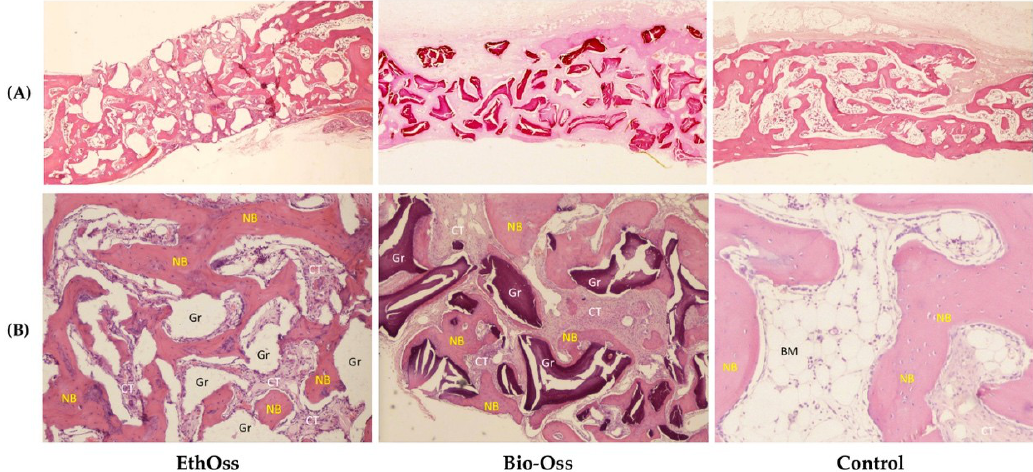
Figure 5. Histological specimens at eight weeks of healing (Hematoxylin and Eosin staining). ( A ) Cross-sections of the grafted and nongrafted sites (original magnification 5 × ); ( B ) EthOss and Bio-Oss particles (Gr) are embedded in well-perfused connective tissue (CT) and newly-formed bone (NB). Control group showing newly-formed bone trabeculae, bone marrow, and connective tissue (original magnification 50×).